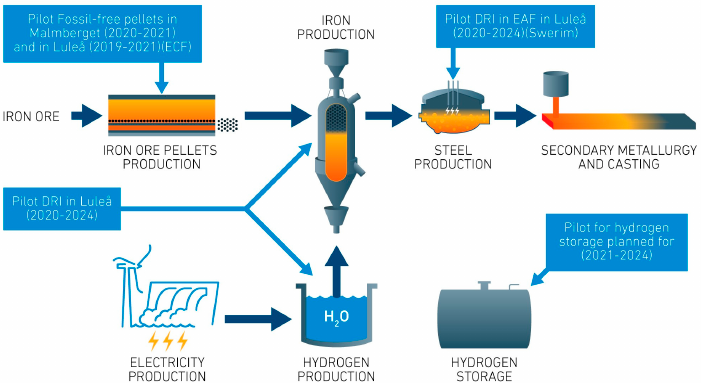
Figure 9. Pilot projects included in the HYBRIT initiative: Pilot for fossil-free pellets, pilot for hydrogen storage, direct reduction of iron ore (DRI) pilot, and electric arc furnace (EAF) pilot.